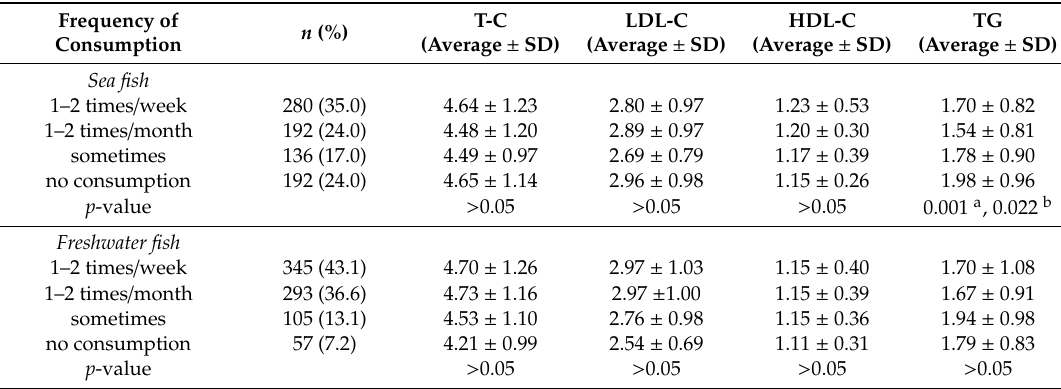
Table 6. E ff ect of the frequency of consumption of fish on lipid